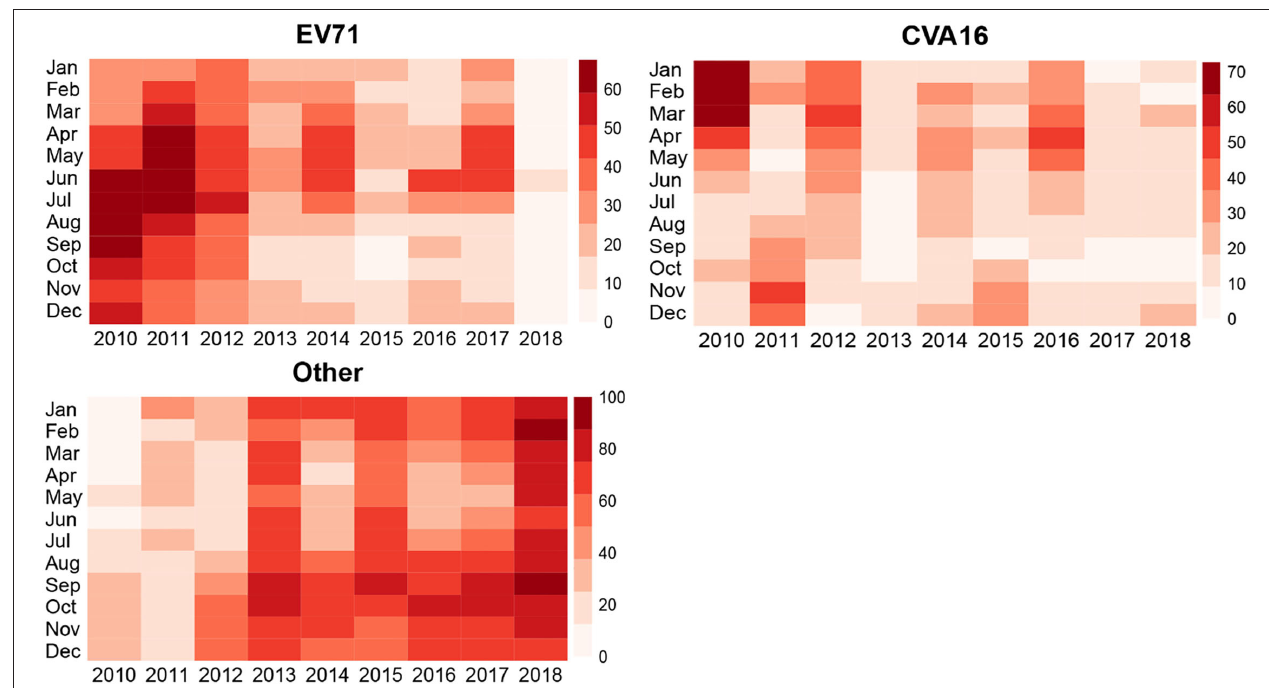
FIGURE 4 | Relationships between different enteroviruses of HFMD cases and temperature and humidity in Zhejiang province, China from 2010 to